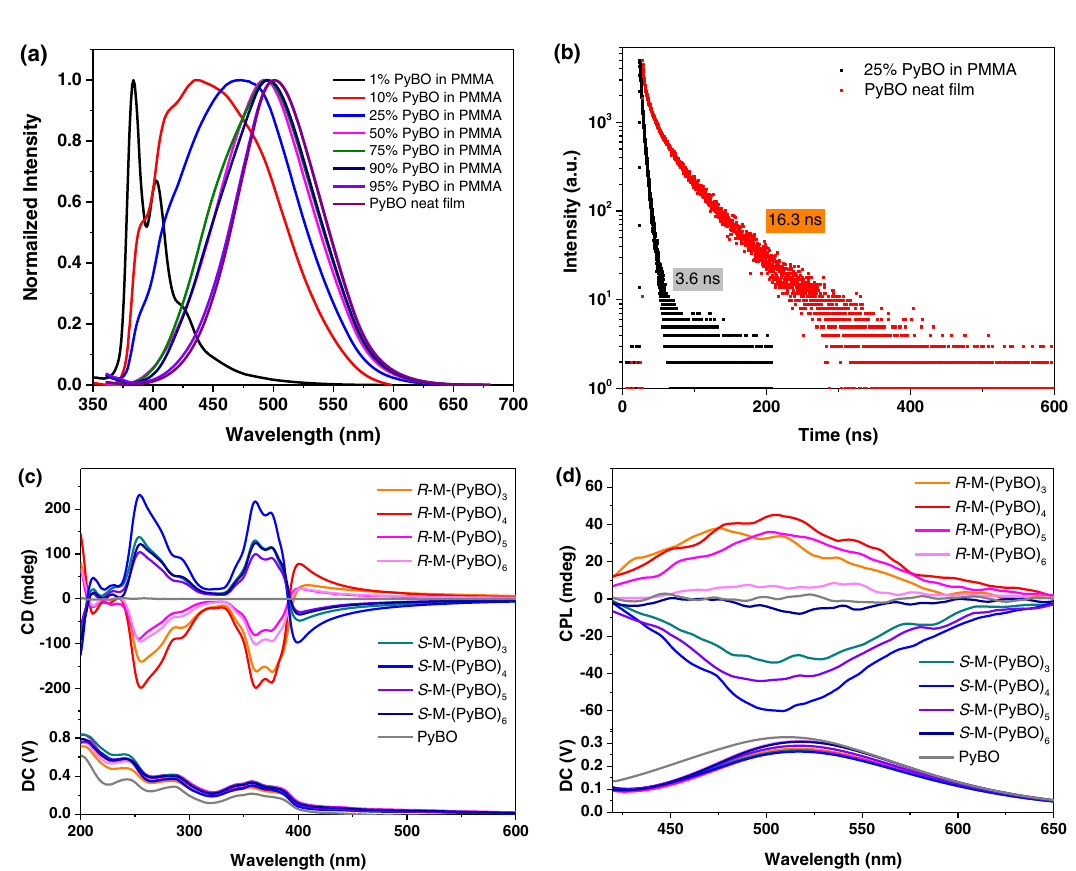
Fig.2|Opticalpropertiesandchiralopticalproperties.a FLspectraoftheblend fi lmsdopingPyBOinmatrixmaterialPMMA(wt%ofPyBOfrom1to95%)andPyBO neat fi lm ( λ ex =330nm); b The fl uorescence decay of the blend fi lm doping 25wt% PyBOinPMMA( λ em =460nm)andPyBOneat fi lm( λ em =500nm); c CDspectraand